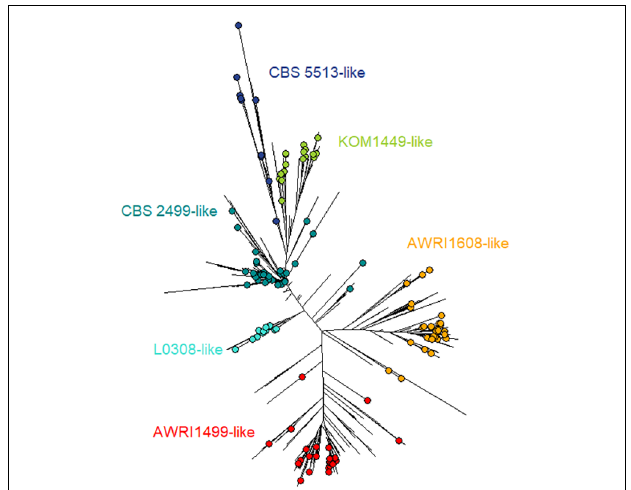
FIGURE 1 | Dendrogram tree showing the 145 phenotyped B. bruxellensis isolates. The dendrogram tree includes 1488 isolates, and was built using 12 microsatellite markers, Bruvo’s distance, and NJ clustering, as described previously (Avramova et al., 2018). The 145 isolates used in this work are represented by colored circles. The six different colors correspond to the main genetic groups identified and were named from one isolate (e.g., L0308-like means genetic group close to L0308